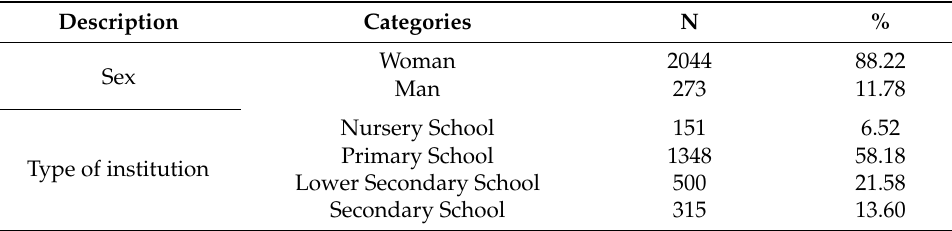
Table 1. Characteristics of the respondents ( n =